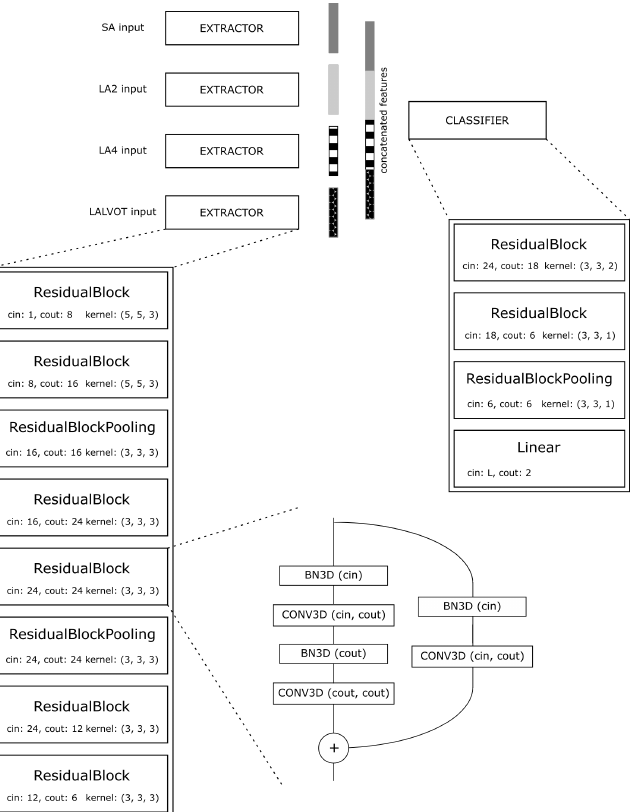
Figure 4. The schematic architecture of the model. Each view has an extractor and the output features from the extractors aggregated by concatenating the features along the channel dimension. This is the ensemble of the views. The extractor and the classifier are built from 3D residual blocks. The architecture of the 3D ResNet blocks can be seen in the middle of the image. The ResidualBlock and the ResBlockPooling differ in the strides. For the pooling block, the first convolution and the convolution on the skip branch have stride 2; otherwise, it is 1. The activations are ReLUs, which were applied after the batch normalization layers. In the ResidualBlock version, we applied padding in each convolution, while in pooling, we applied padding in the last convolution of the straight branch. Padding was: ( k − 1 ) /2 for each dimension. The kernel sizes were chosen as odd values in each